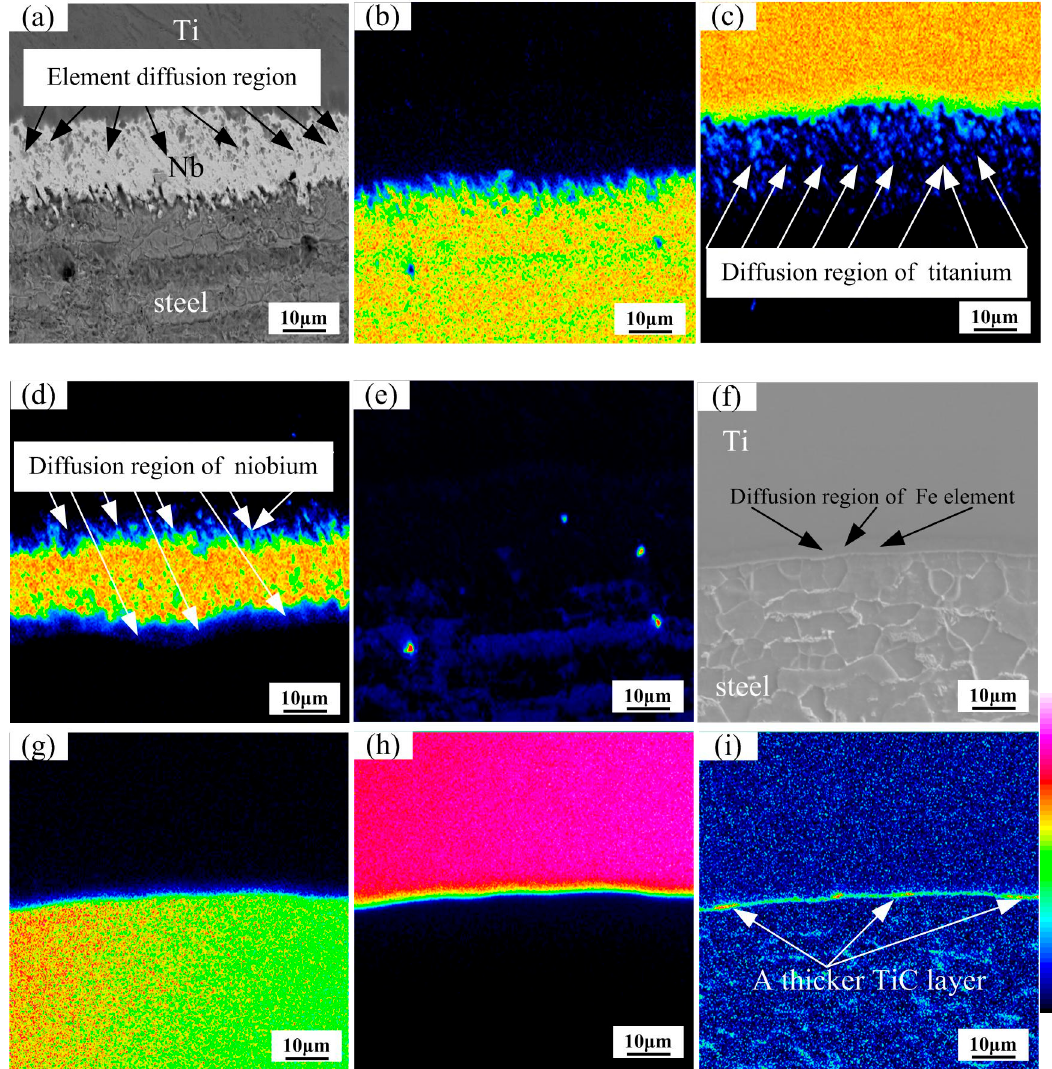
Figure 7. Map distribution micrographs of various elements at interface of the clad plates at 1000 °C.